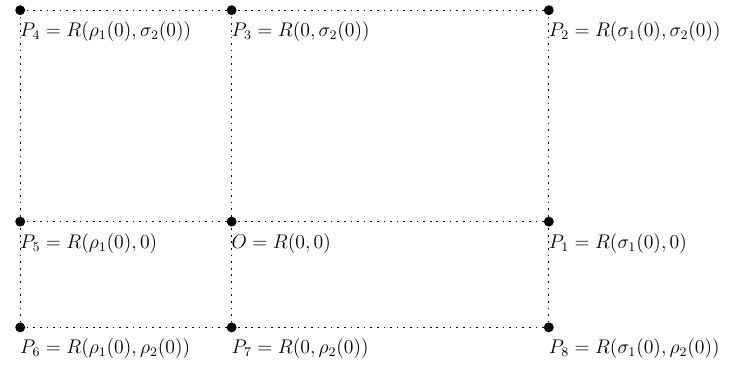
Fig. 2 Eight neighbouring non-uniform data points of O = R ( 0 , 0 )